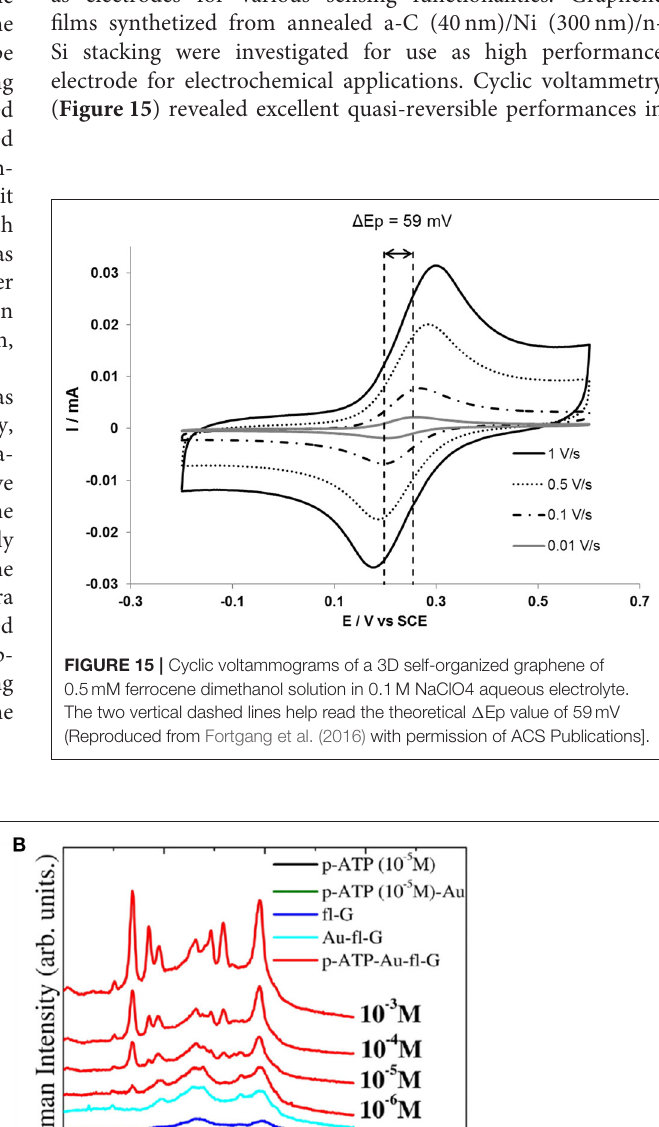
Frontiers in Chemistry |